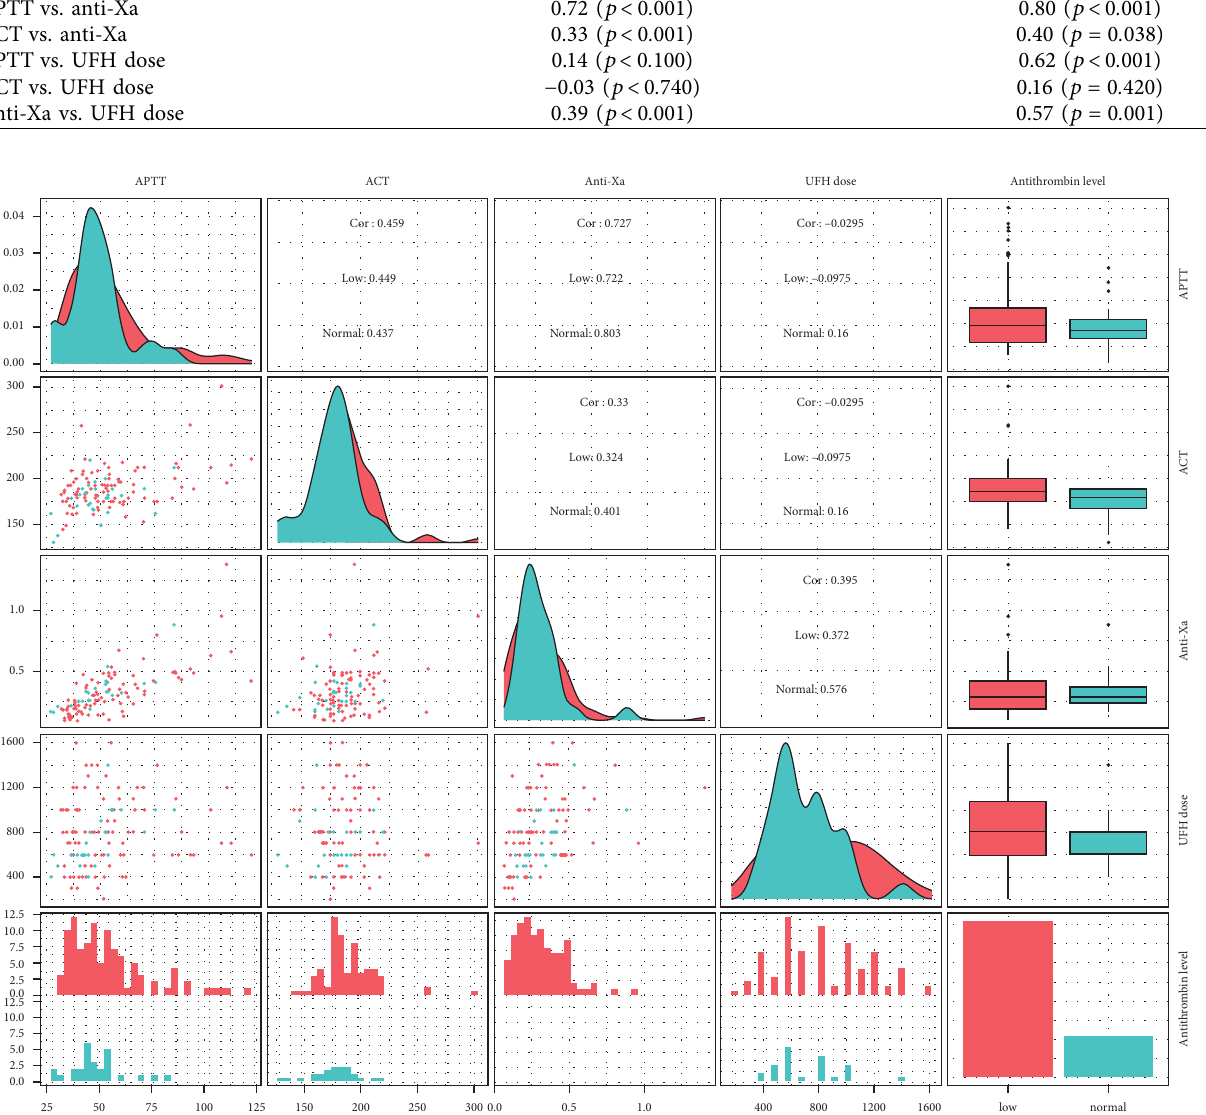
Figure 2: Correlation between ACT, APTT, anti-Xa and UFH dose values based on antithrombin groups.